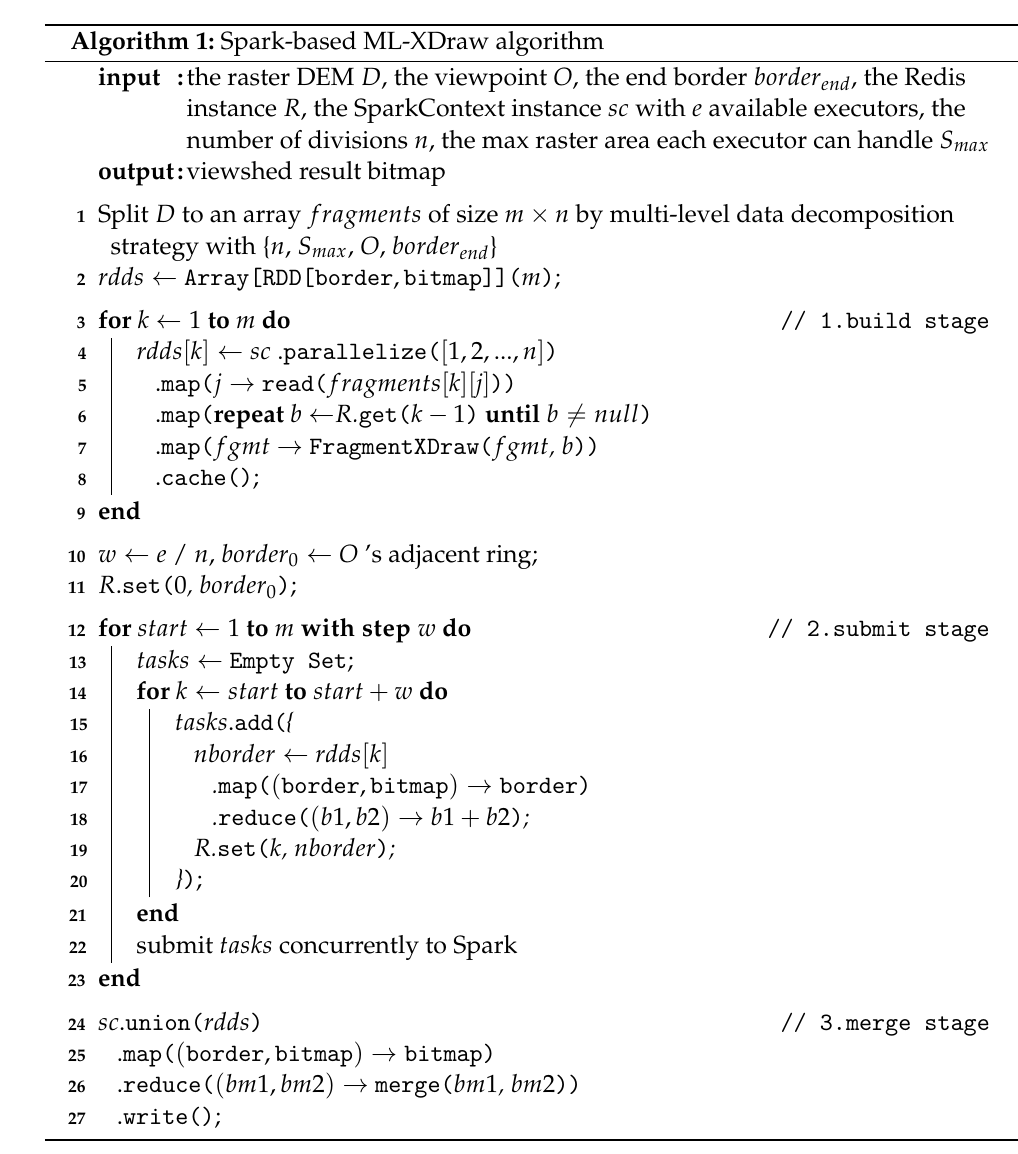
Algorithm 1: Spark-based ML-XDraw